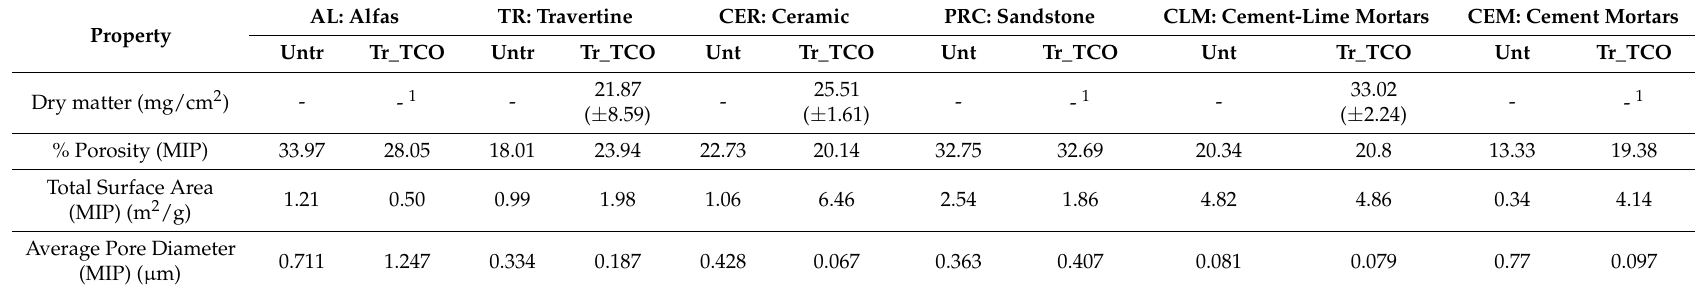
Table 1. Dry matter (mg/cm 2 ) of the xerogel, % Porosity, Total Surface Area (m 2 /g) and Average Pore Diameter ( µ m) of untreated and treated substrates with TCO. AL: Alfas TR: Travertine CER: Ceramic PRC: Sandstone CLM: Cement-Lime Mortars CEM: Cement Property